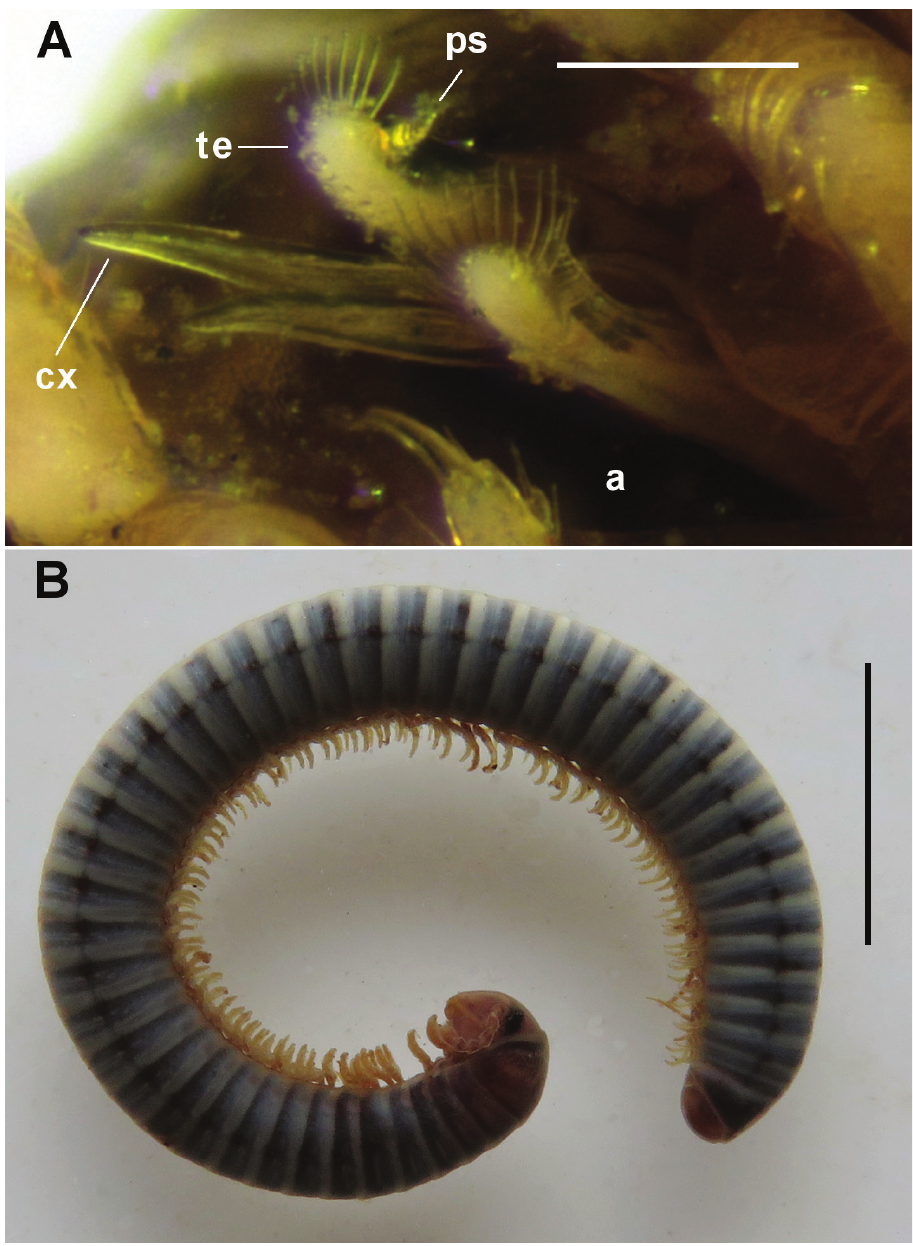
Figure 11. Equestrigonus tasmaniensis gen. n., sp. n. A Gonopod aperture (a) of male paratype QVM 23:11638, left ventrolateral view, showing protruding tips of anterior gonopods. cx = right coxite tip (“prick spur”), te = right telopodite tip (“rowel spur”), ps = pseudoflagellum B Male holotype QVM 23:54173, habitus. Scale bars: A = 0.2 mm, B = 5